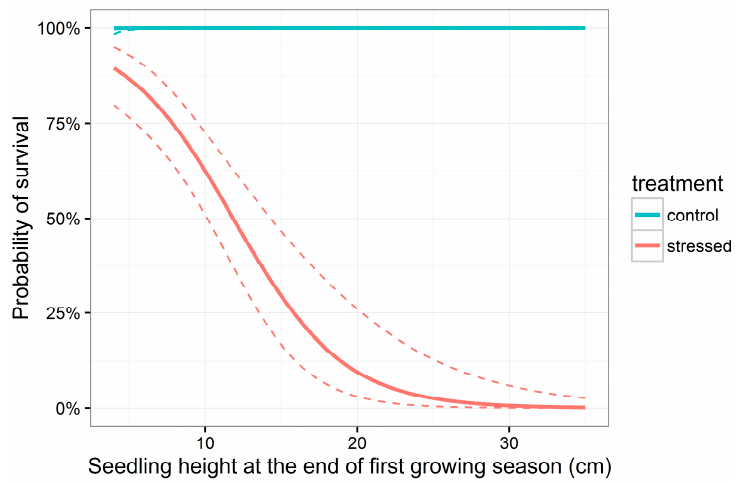
Figure 1. Modelled probability of survival depending on the plant height at the end of the first growing season. The mean adjusted relative extractable water of the pots in the control and treated group of plants was applied to calculate the probabilities; 95% confidence intervals are shown with dashed lines. Table 2. Model statistics for the general linear mixed model of the binary response variable survival.